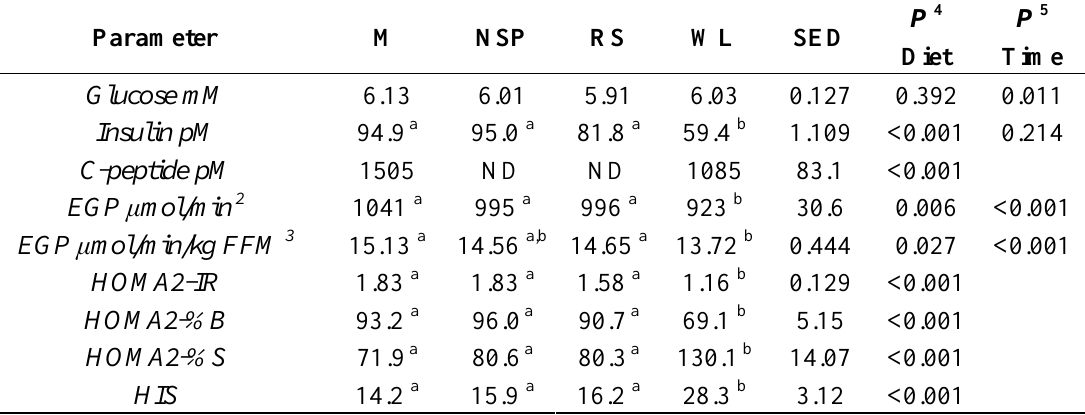
Table 1. Effect of diet and time of sampling on various parameters 1 after an overnight fast following consumption of either a 7-day maintenance (M), or 21-day high non-starch polysaccharide (NSP), high resistant starch (RS) or weight loss (WL) diets by obese men ( n =